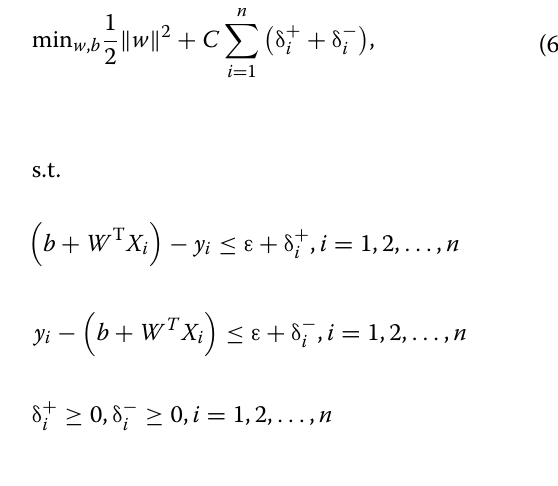
(4) P max arable output data: